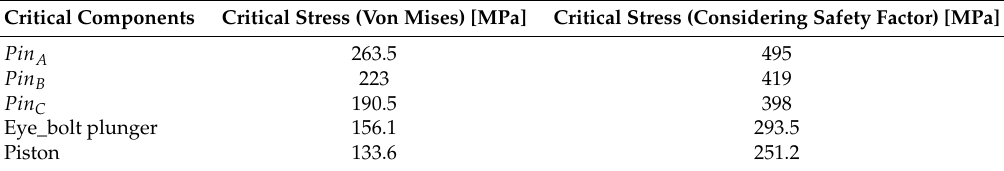
Table 3. Hydraulic damper’s components stress.